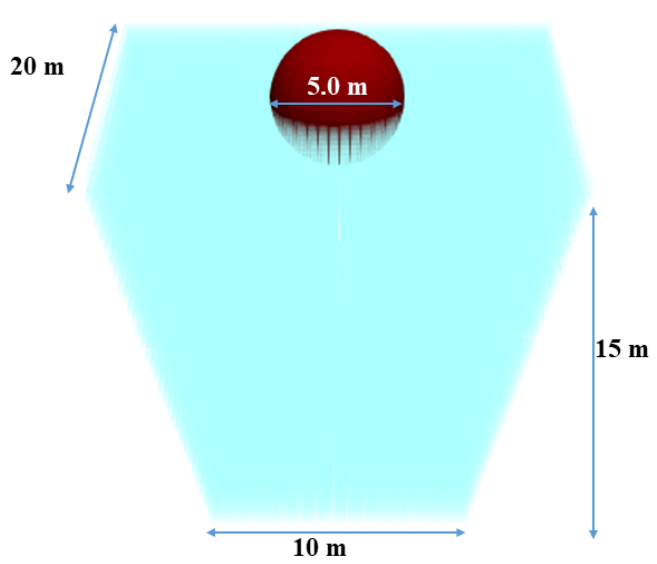
Figure 5. Dimensions of the numerical wave basin for hydrodynamic coefficients and drag coefficient test for a heaving